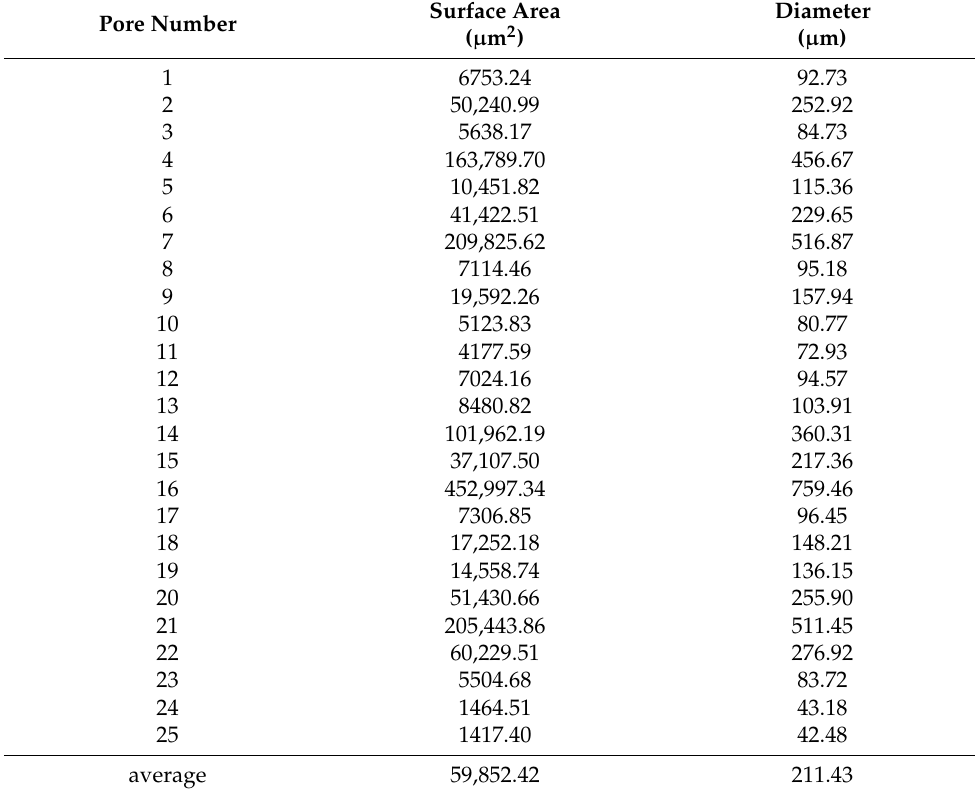
Table 6. Measurement results of pores extracted from SEM images for carbon sample M3.